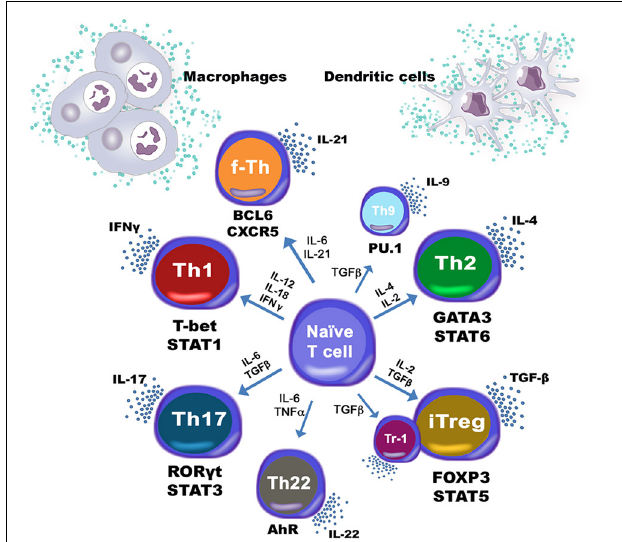
FIGURE 2 | Heterogeneity of CD4 + T cell subsets. T helper type 1 (Th1), type 2 (Th2), type 17 (Th17), type 9 (Th9) and type 22 (Th22), Follicular T helper cells (Tfh), and induced regulatory T cells (iTreg) as well as type 1 regulatory T cells (Tr1) are induced based on multiple cytokines being produced by dendritic cells and macrophages among other immune